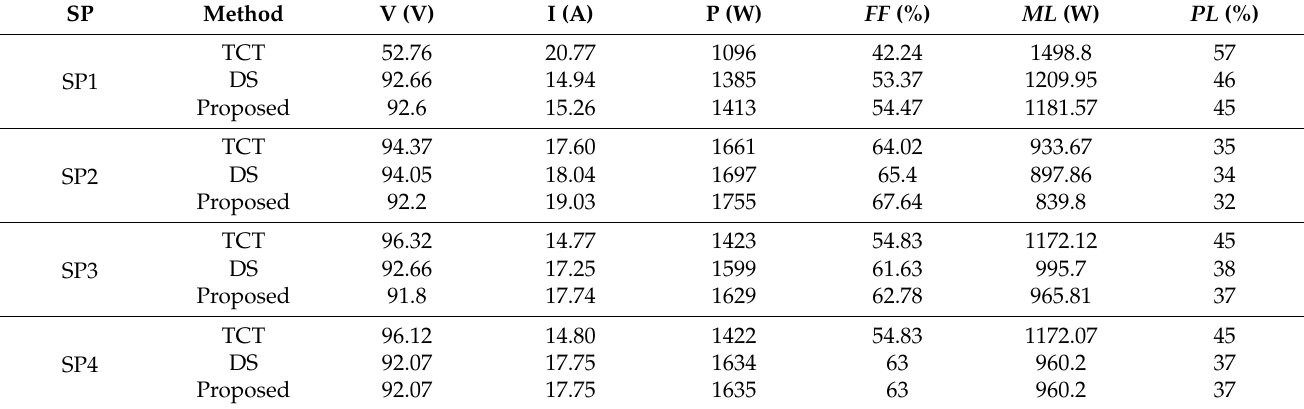
Table 2. Performance parameter calculation for TCT, DS and the sum of position square